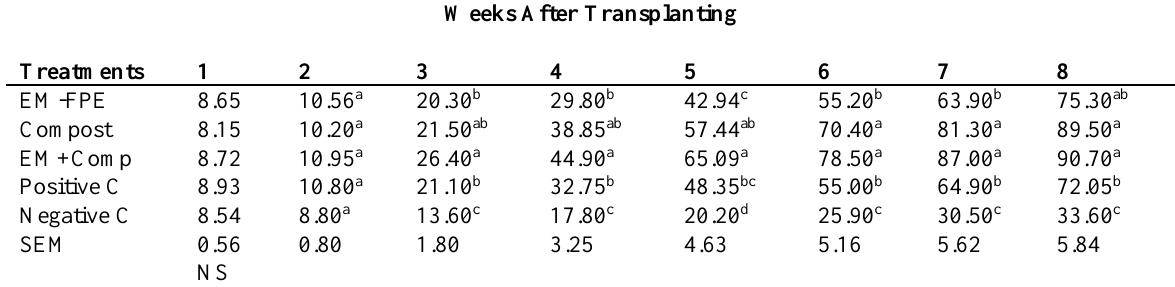
Weeks After Transplanting